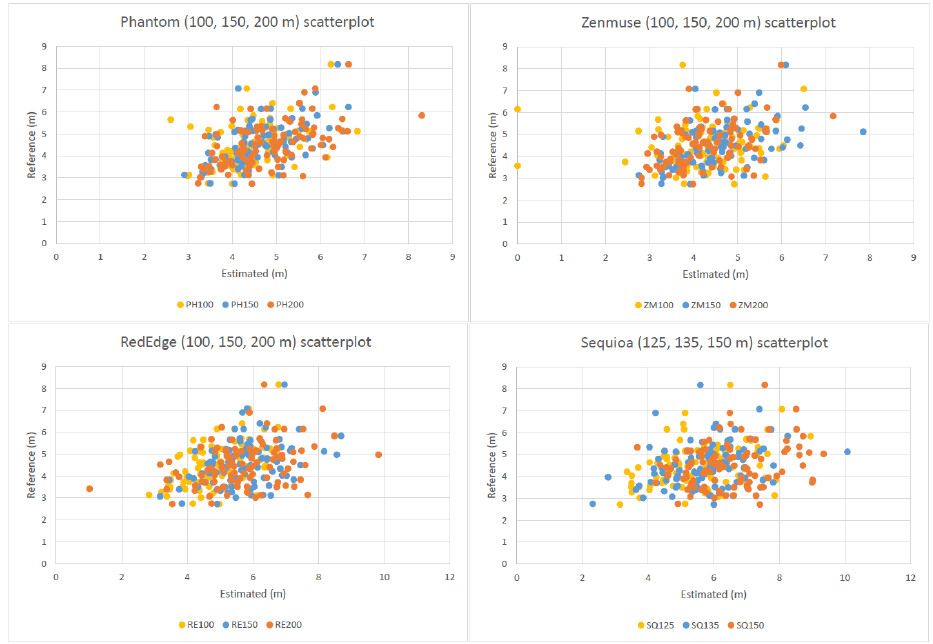
Figure A2. Scatterplots showing the association between the manually and automatically delineated tree crowns — examples from Site II.